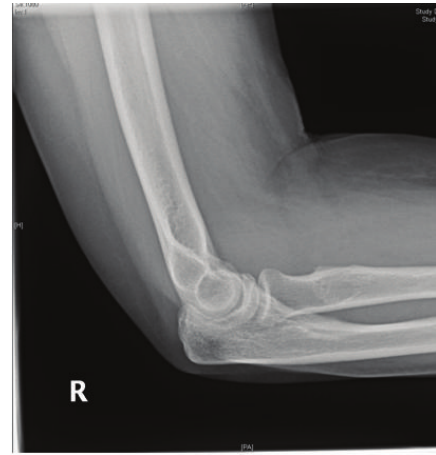
Figure 8: Plain radiograph at